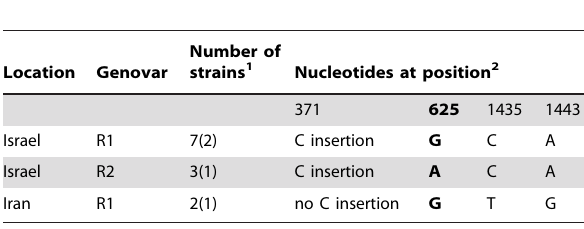
Table 5. Variability and genovar distribution based on the 16S rRNA gene ( rrs ) sequences of B. persica in Israel and